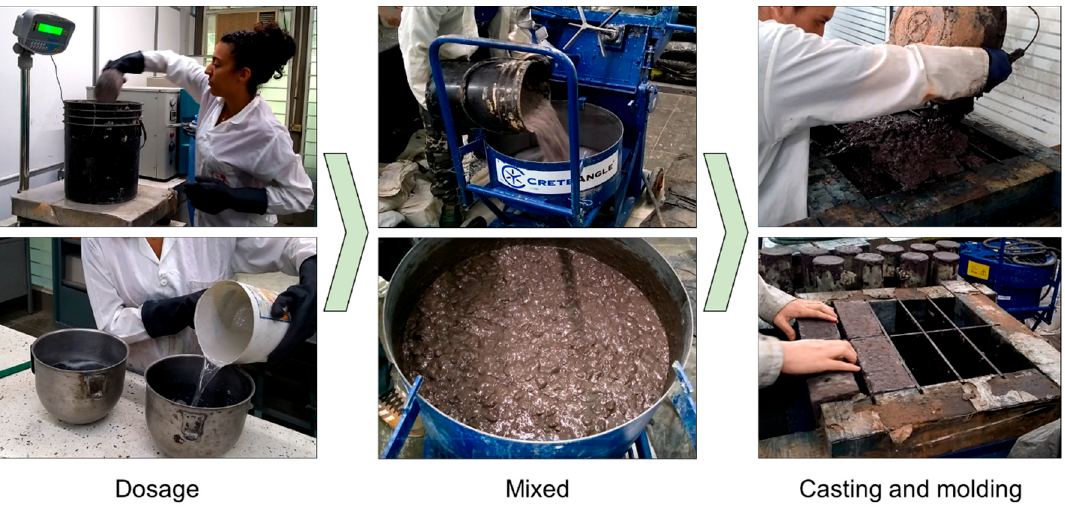
Figure 3. Blocks production process.